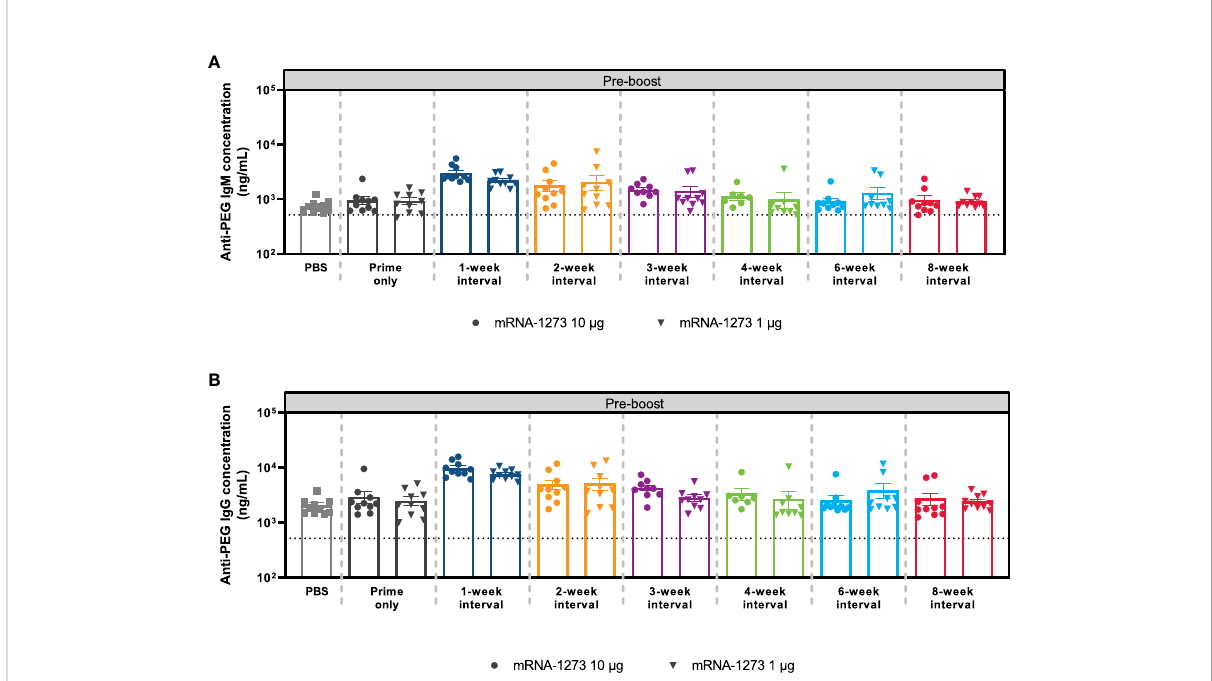
FIGURE 6 Anti-PEG Antibody Responses. The mean ± SEM concentrations of (A) anti-PEG IgM and (B) anti-PEG IgG antibodies at Day 56 (before dose 2) are presented by mRNA-1273 dosing interval schedule (prime only or 1-, 2-, 3-, 4-, 6-, and 8-week intervals) with n=8-10 mice per group. Results of corresponding statistical comparisons between groups are shown in Table S8 and Figure S12. IgG, immunoglobulin G; IgM, immunoglobulin M; mRNA, messenger RNA; PEG, polyethylene glycol; PBS, phosphate-buffered saline; SEM, standard error of the